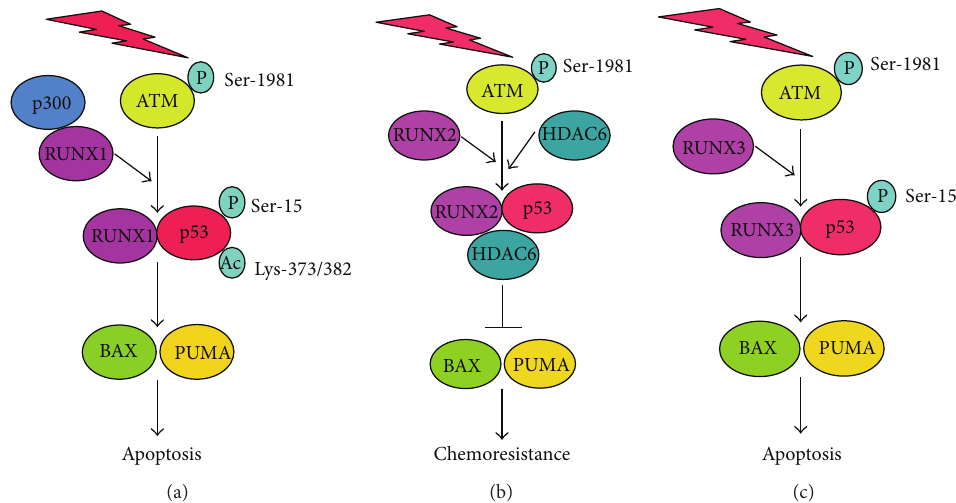
Figure 5: Distinct regulatory role of RUNX family on p53 in response to DNA damage. Under our experimental conditions, RUNX1 as well as RUNX3 acts as a positive regulator for p53 in response to DNA damage, whereas DNA damage-induced proapoptotic activity of p53 is strongly abrogated by